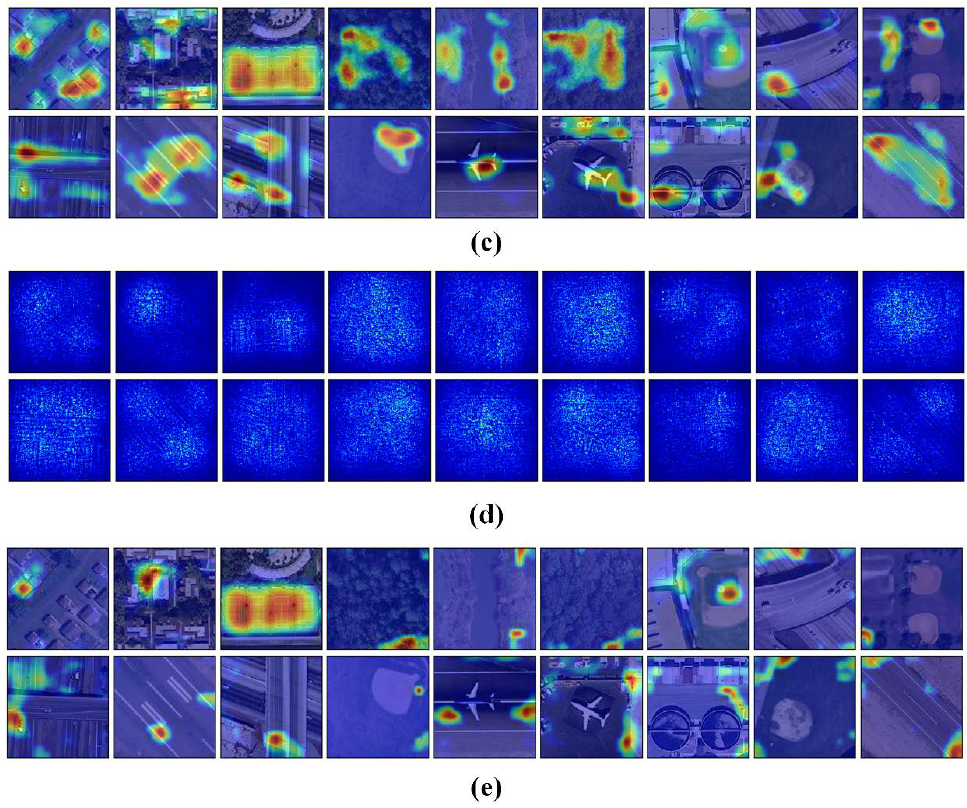
Figure 11. The attention heatmaps and the gradient based class activation maps to show the important regions of the scene images in the UC Merced dataset. ( a ) Original scene images; ( b , d ) are attention heatmaps for CPP-net and SPP-net; ( d , e ) are gradient based class activation maps for CCP-net and SPP-net.